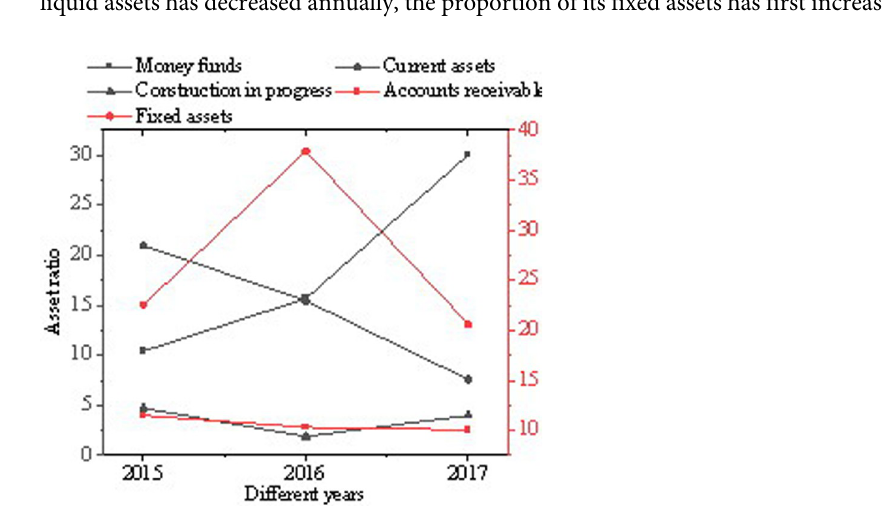
Fig 2. Major asset accounting results of SF Express from 2015 to